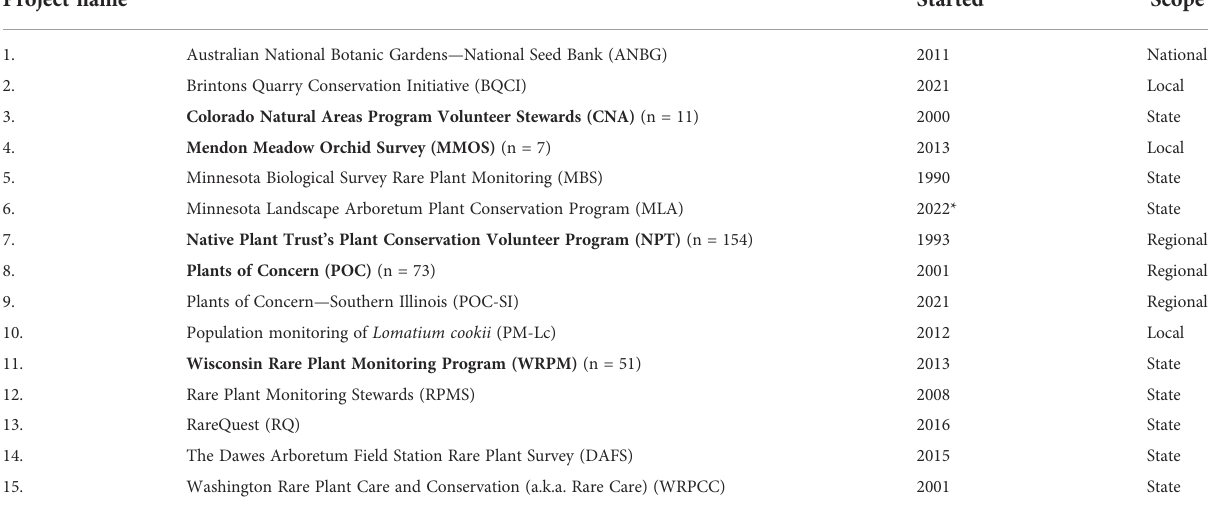
TABLE 1 Projects included in the summary of project manager survey results. Project